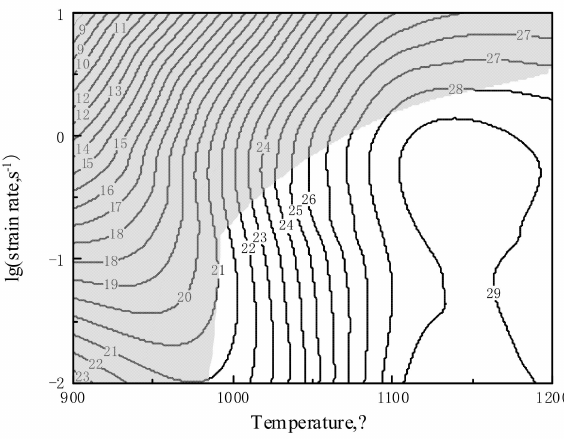
Figure 10. Processing map of tested steel at a strain of